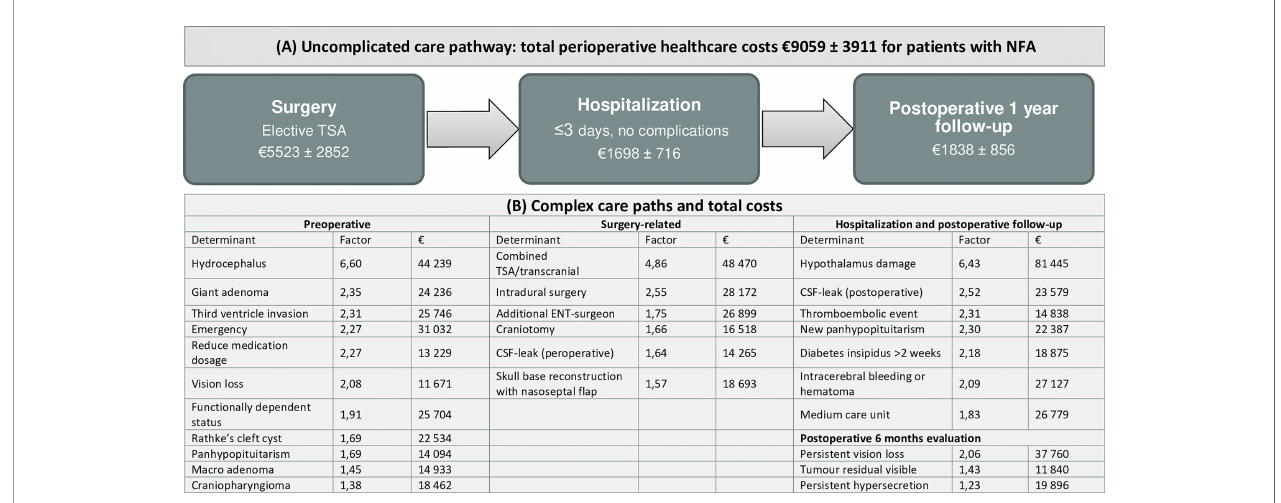
FIGURE 3 | Overview of perioperative healthcare costs for patients undergoing pituitary surgery. (A) To illustrate, the care trajectory of patients with non-functioning micro- or macroadenoma undergoing transsphenoidal adenectomy is shown as an example for an uneventful case. (B) Cost determinants are summarized in coef fi cients (calculated by dividing total costs of the determinant by total costs of the reference group) and total perioperative costs, based on multivariable analyses ( Supplemental Table S1 ) E.g., total healthcare costs for patients with postoperative CSF leak is 2,52 times higher compared to patients without CSF leak. NFA, non-functioning adenoma; TSA, transsphenoidal adenectomy; ENT, ear, nose and throat; CSF, cerebrospinal fl